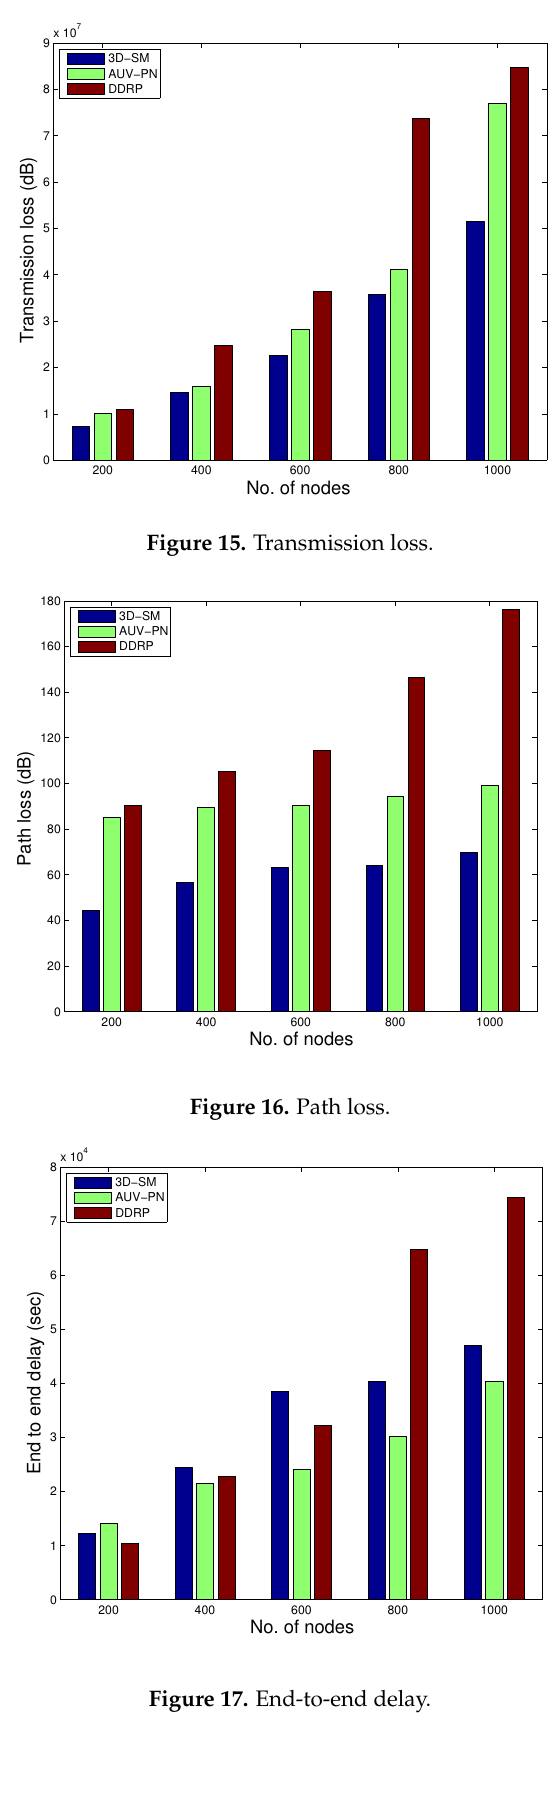
Figure 17. End-to-end